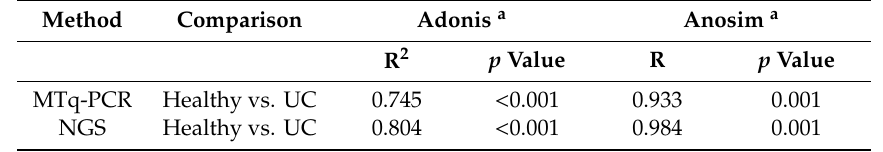
Table 8. Adonis and Anosim statistical analyses between NGS and